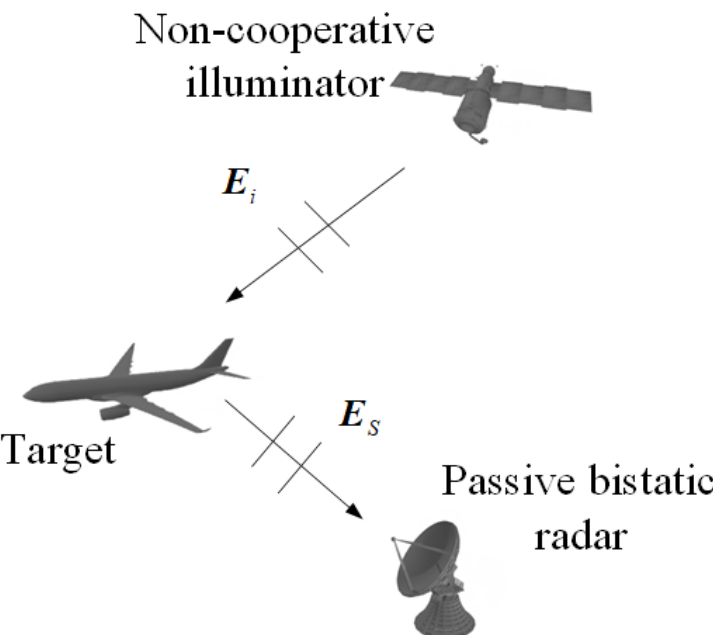
Figure 1. Illustration of the passive bistatic radar system based on a non-cooperative satellite-borne illuminator.